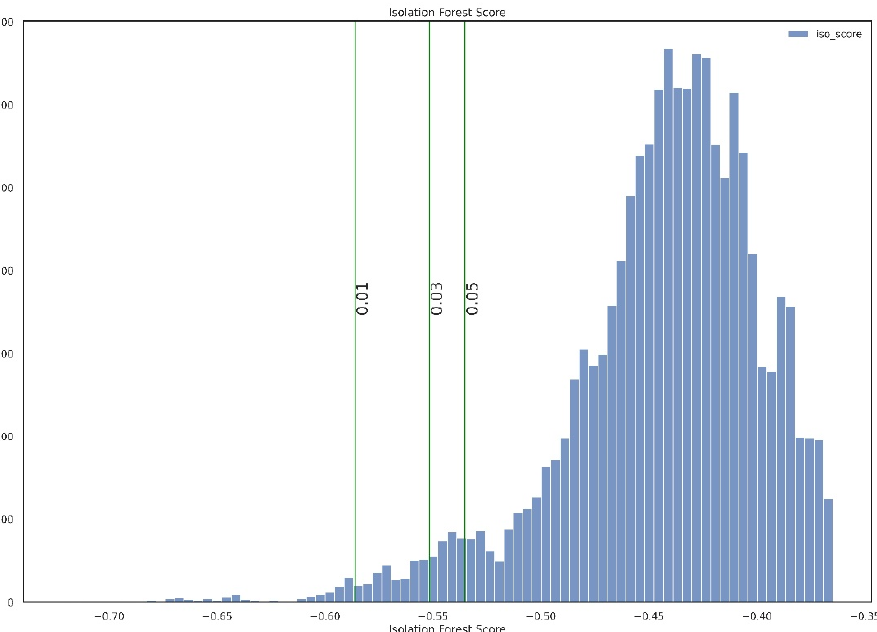
Figure 9. Histogram of anomalous score in different percentages.